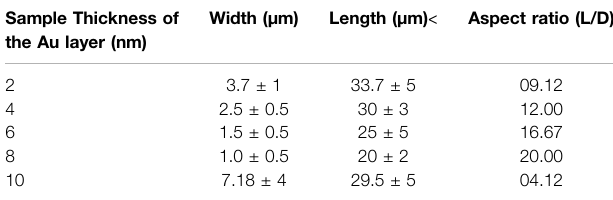
TABLE 1 | Average dimensions and aspect ratio of nanobelts with respect to Au thickness. Sample Thickness of the Au layer